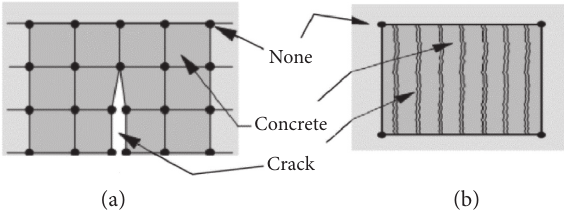
Figure 5: Concrete cracking model [31]: (a) discrete and (b) smeared.